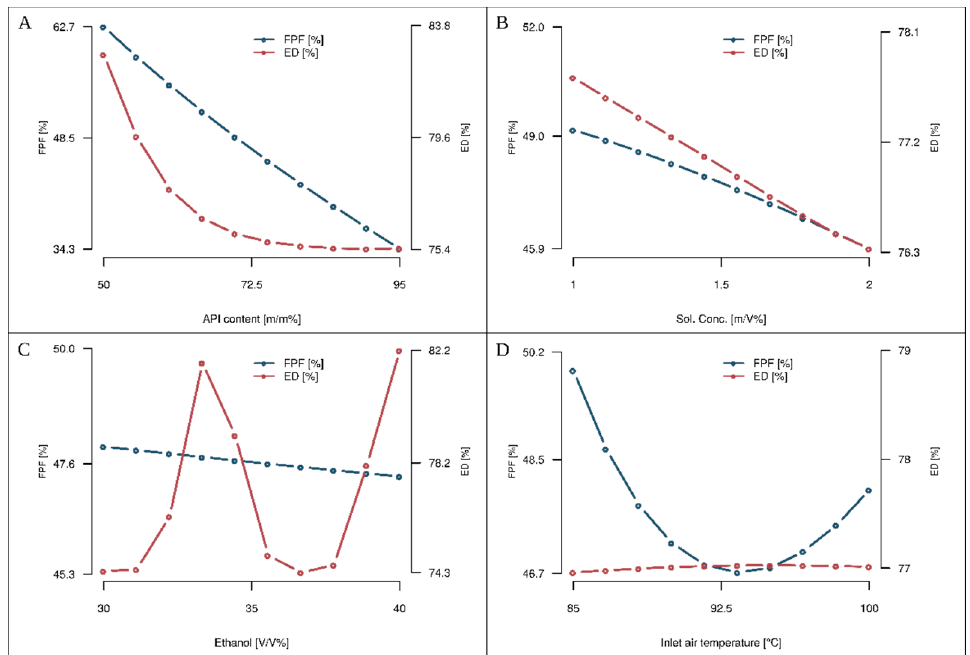
Figure 5. The relationship between ED and FPF predicted by models and numerical value of input variables: ( A ) API to excipient ratio in feed solution; ( B ) the total concentration of substances dissolved in feed solution; ( C ) ethanol to water ratio in solvent applied in the process; ( D ) the temperature of the air entering the spray drying chamber. FPF—fine particle fraction; ED—emitted dose.